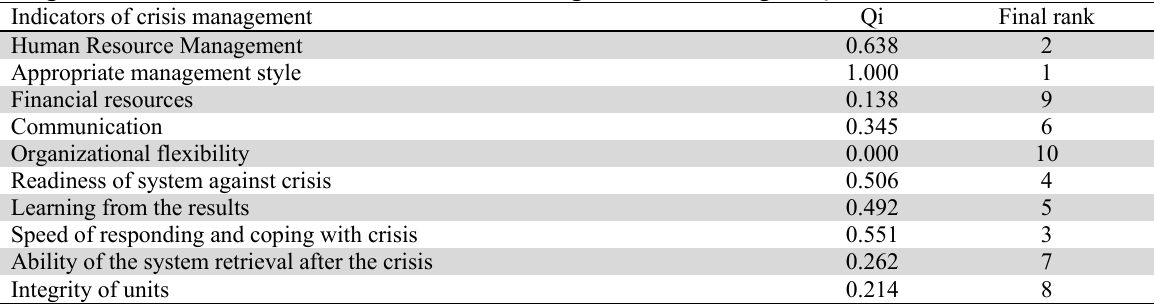
Weight and final rank of each index of crisis management according to Q